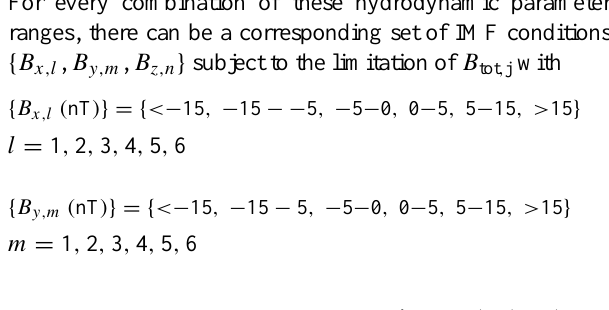
Submitted to Annales Geophysicae , November 22, 2006; revised December 13, 2007.